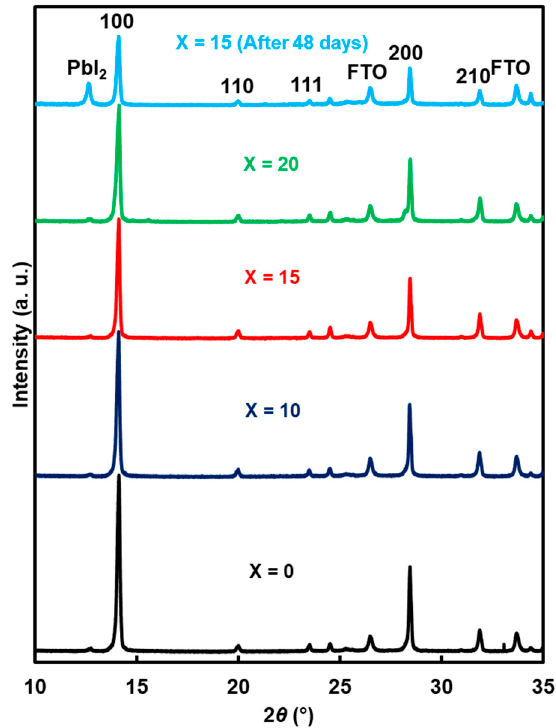
Figure 5. XRD patterns of the MAPbI 3 /(DPPS) ( X mg mL − 1 ) perovskite solar cells.